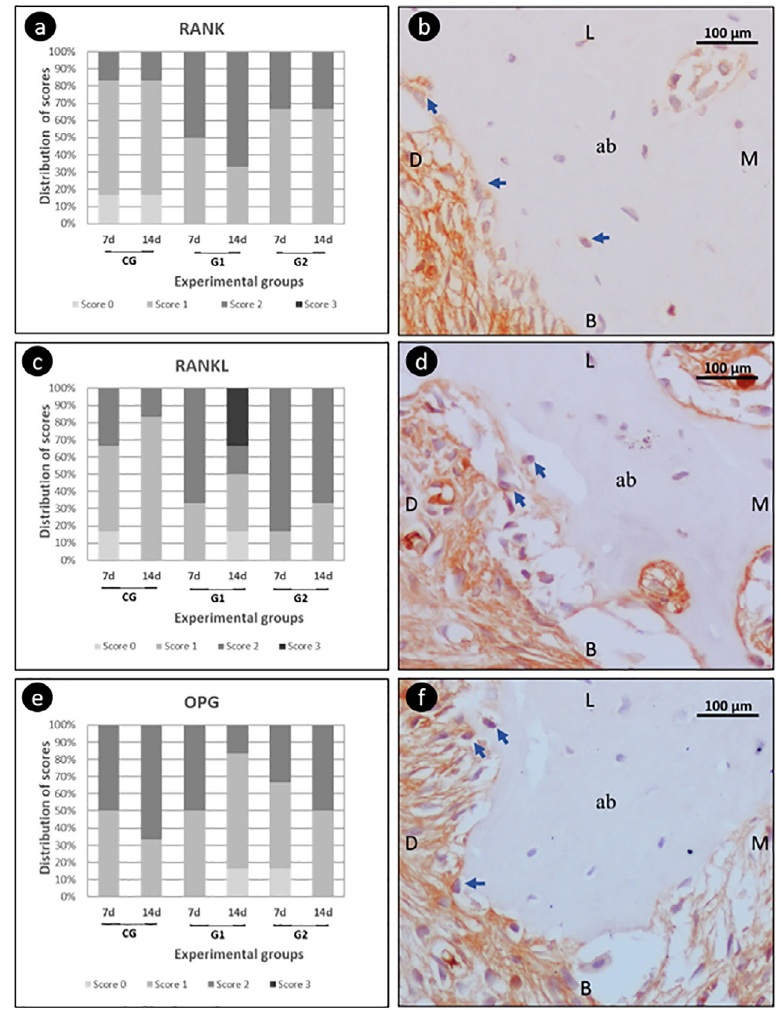
Figure 4- RANK, RANKL, OPG